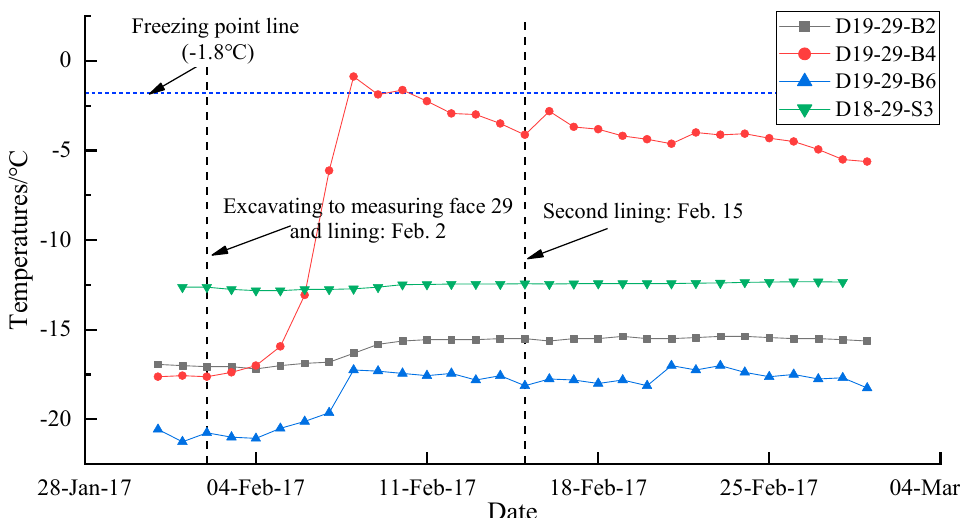
Figure 9. Temperature variation with time of measuring points at area A4 (see Figure 4).